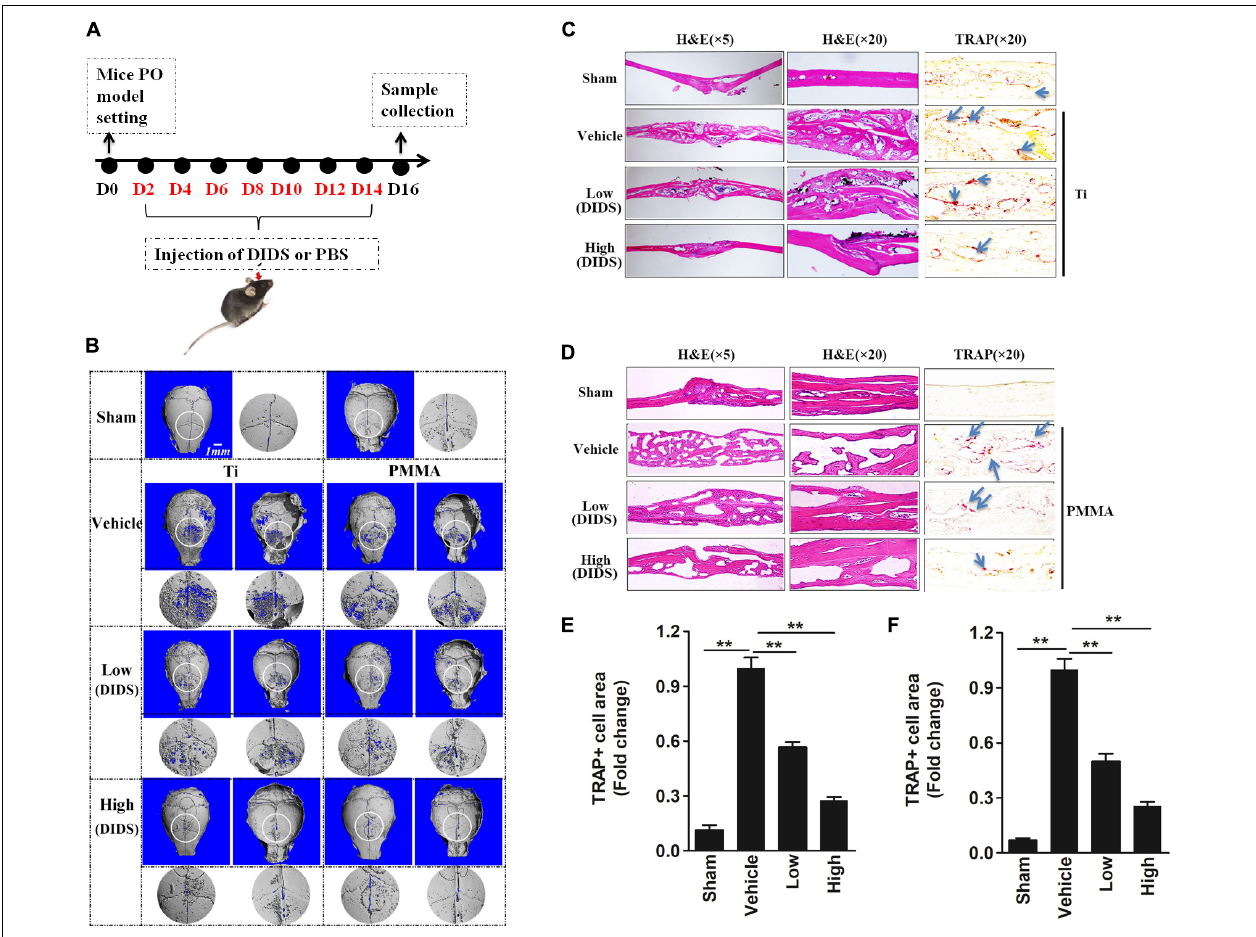
FIGURE 4 | DIDS, an anion exchange inhibitor, prevented wear-particle-induced osteolysis in a mouse calvarial model. (A) Timeline of the experiment. (B) µ -CT 3D reconstruction. The obverse, the reverse and the enlarged interested area around the cranial raphe were shown. Hematoxylin and eosin (HE) staining and tartrate-resistant acid phosphatase (TRAP) staining for the Ti particle model (C) and PMMA model (D) . Determination of the area of TRAP-positive cells for the Ti particle model (E) and PMMA model (F) ( ∗ P < 0.05; ∗∗ P < 0.01). PO, periprosthesis